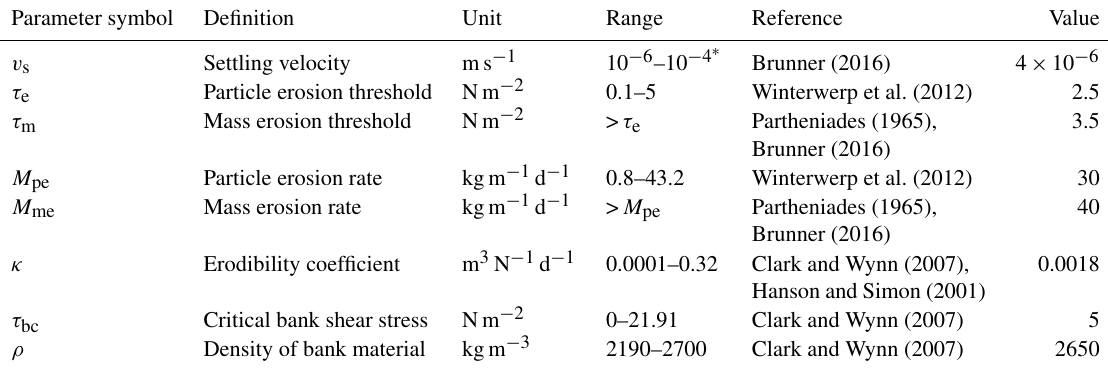
Table 3. Parameters of the river sediment-transport